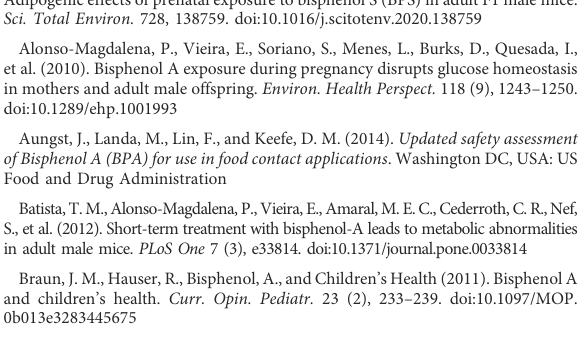
SUPPLEMENTARY FIGURE 1 BPS exposure does not impact litter size or sex